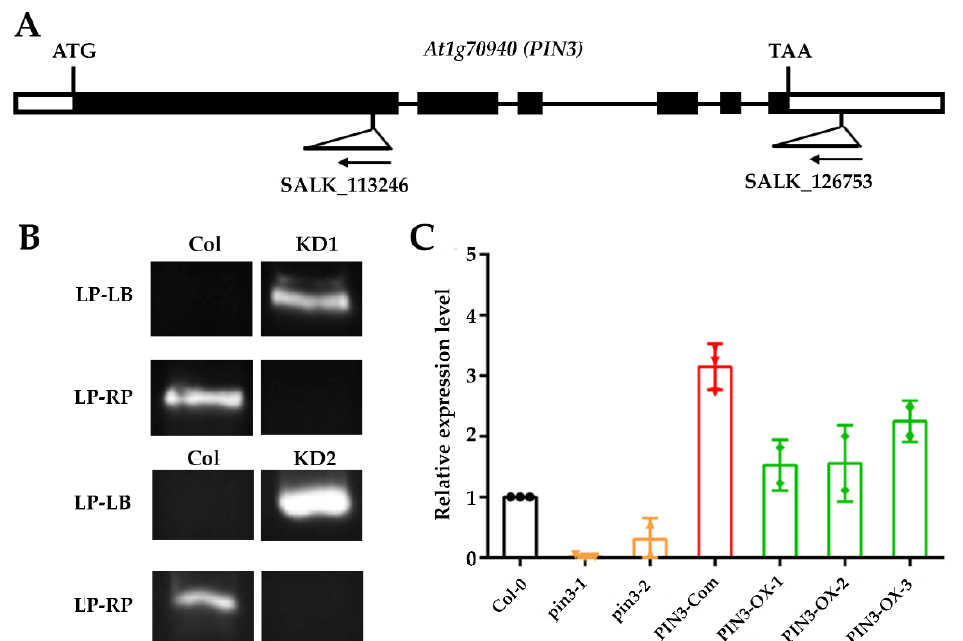
Figure 3. Identification of homozygous T-DNA insertion knockdown (KD) lines and PIN3 gene expression levels in the inflorescences of different lines. ( A ) Homozygous T-DNA insertion knockdown (KD) lines used in this study. The figure shows location of T-DNA insertion in the gene. The arrow indicates the direction of T-DNA insertion (reverse). ( B ) The left and right genomic primers LP and RP, and the T-DNA border primer LB used for validation of homozygous KD lines. The gel photo shows that the LP-LB primer pair was amplified, while the genomic primer pair LP-RP was not amplified, confirming that the KD mutants was homozygous. ( C ) qRT-PCR of PIN3 genes in pin3-1 , pin3-2 , PIN3-Com (complementation lines), PIN3-OX-1 (overexpression lines), PIN3-OX-2, and PIN3-OX-3 flowers.